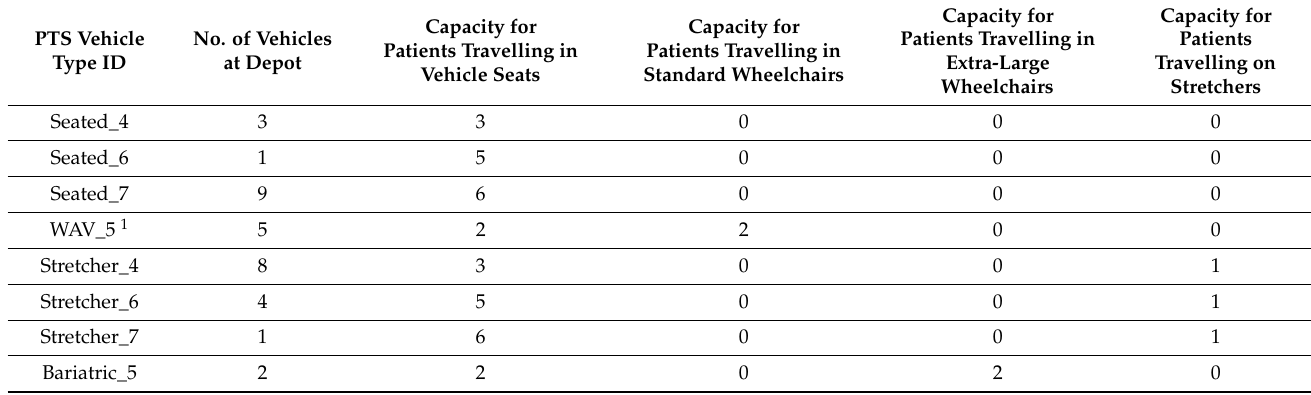
Table 2. Capacities of PTS vehicles based at the Eastleigh depot.